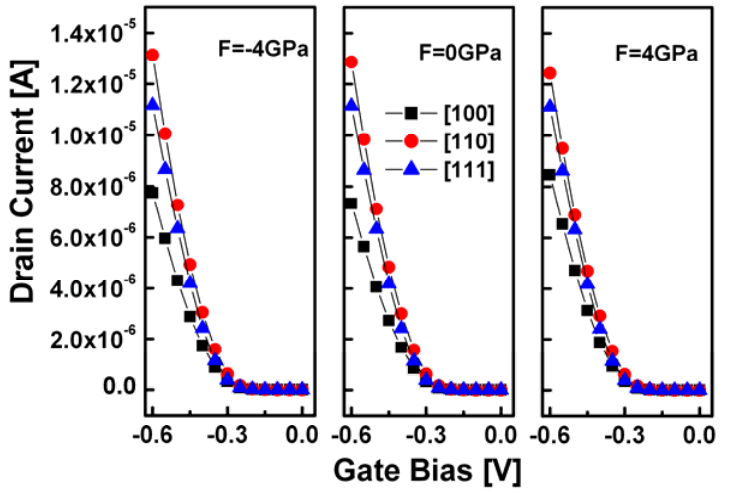
-V curves for p-type strained and unstrained SiNW FETs with various Figure 6. The I DS GS channel orientations at V = – 0.6 V. The oxide thickness is assumed to be 1 nm and the DS temperature is 300